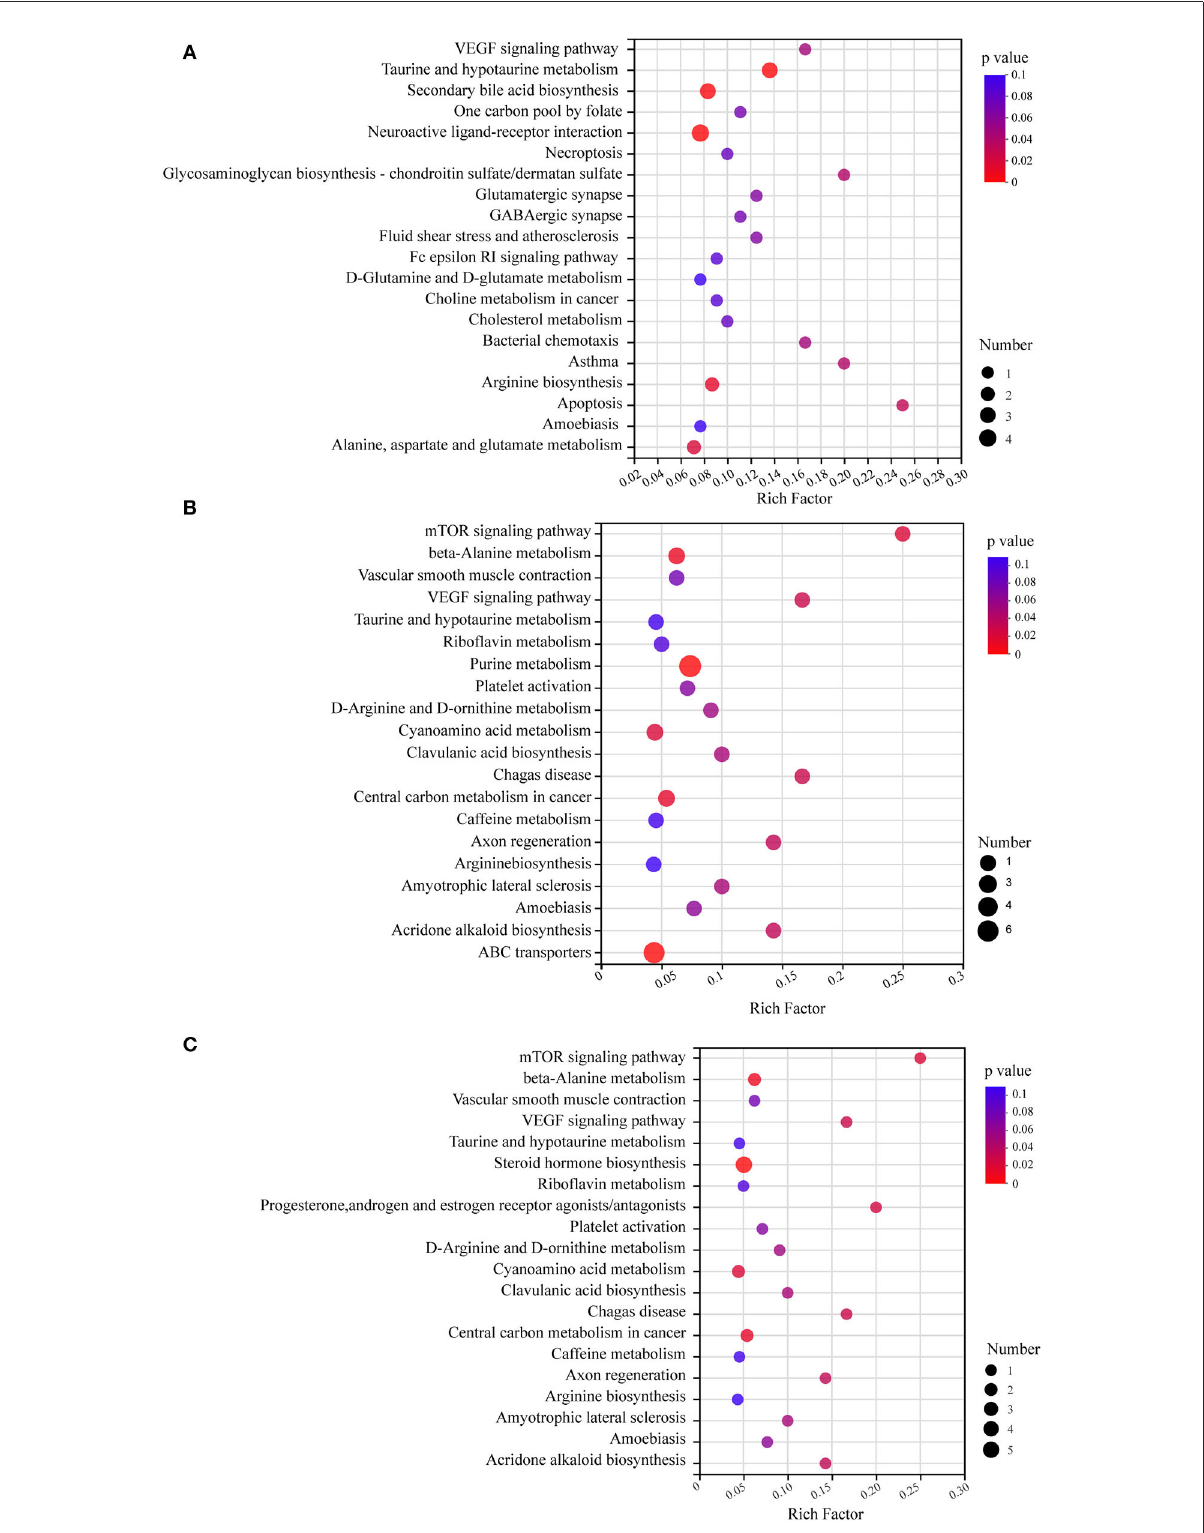
FIGURE6 KEGG pathway enrichment analysis bubble diagram. The top 20 metabolic pathways were selected ( n = 8). (A) HFD vs. NC. (B) MSDF vs. HFD. (C) HSDF vs. HFD. The horizontal coordinate is the rich factor, calculated as several differential metabolites/total metabolites in each pathway. The size of the bubbles in the graph represents the number of metabolites enriched to the metabolic set in that pathway and the color of the bubbles indicates the size of different enrichment significance p